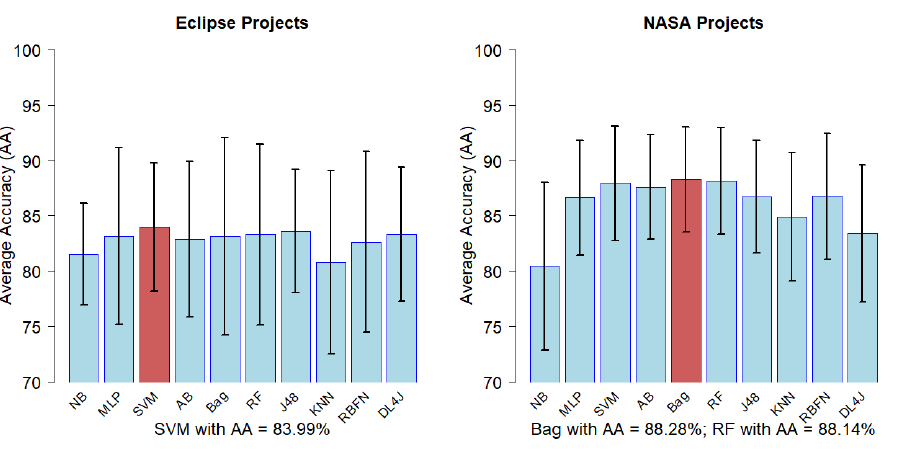
Figure 3. Average Accuracy for the NASA and Eclipse